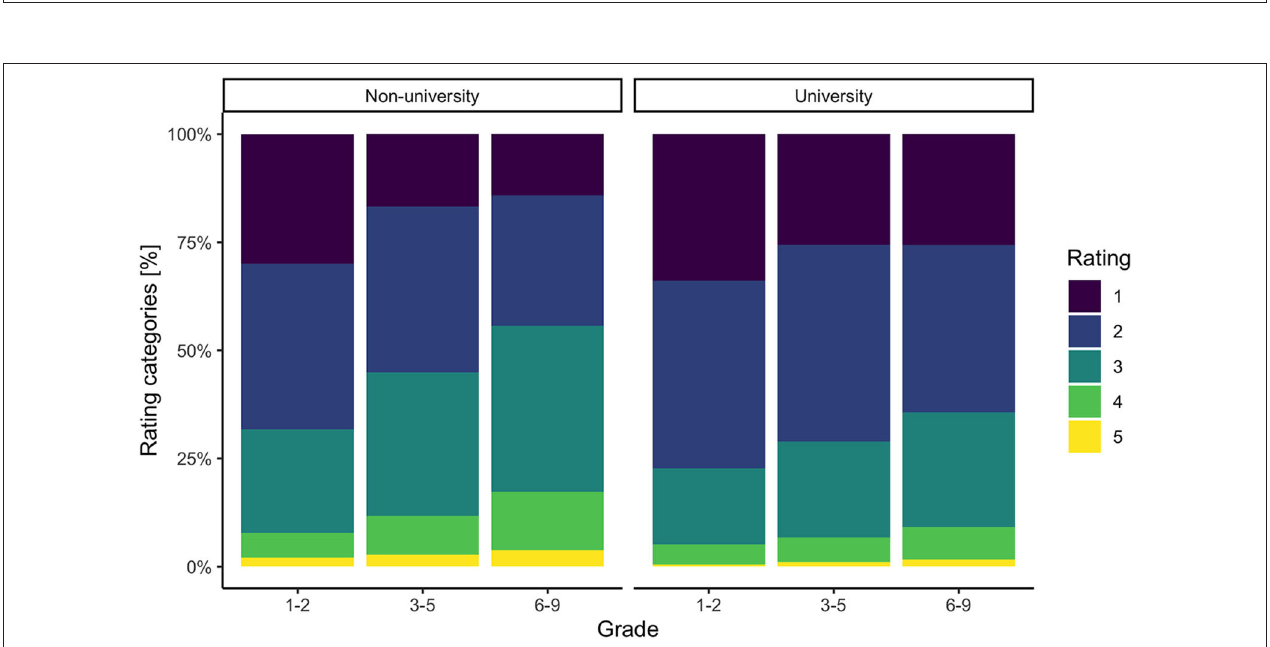
FIGURE 3 | Parental estimates of the frequency with which they work on five different educational activities: explaining homework instructions, helping with completion of homework, explaining new topics, explaining implications and other contexts, and checking the quality of the child’s work and whether the answers are correct (Q11 from the survey). Breakdown based on the child’s grade and the parents’ highest level of education obtained.